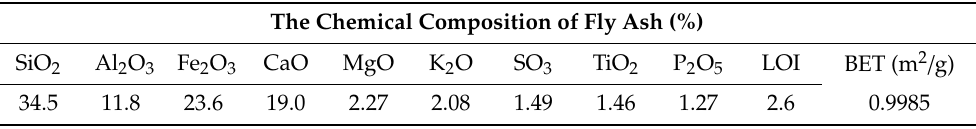
Figure 1. Field emission SEM (FESEM) micrographs: ( a ) Fly ash (spherical particles); ( b ) polyvinyl alcohol (PVA) fiber (diameter of 0.04 mm). Table 1. Elemental composition, loss on ignition (LOI), and surface area of fly ash.